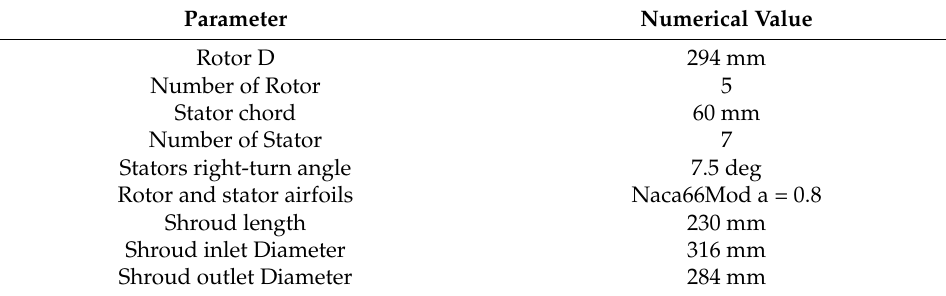
Table 1. Main parameters of pump-jet.